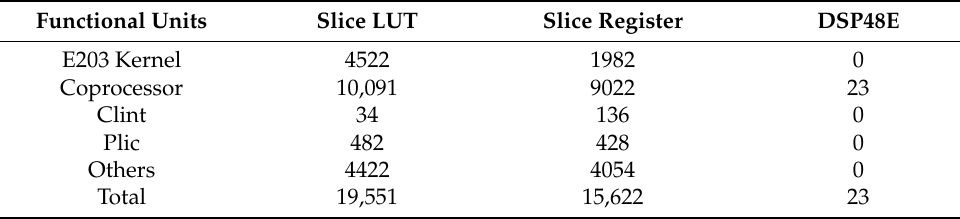
Table 4. E203 SoC resource